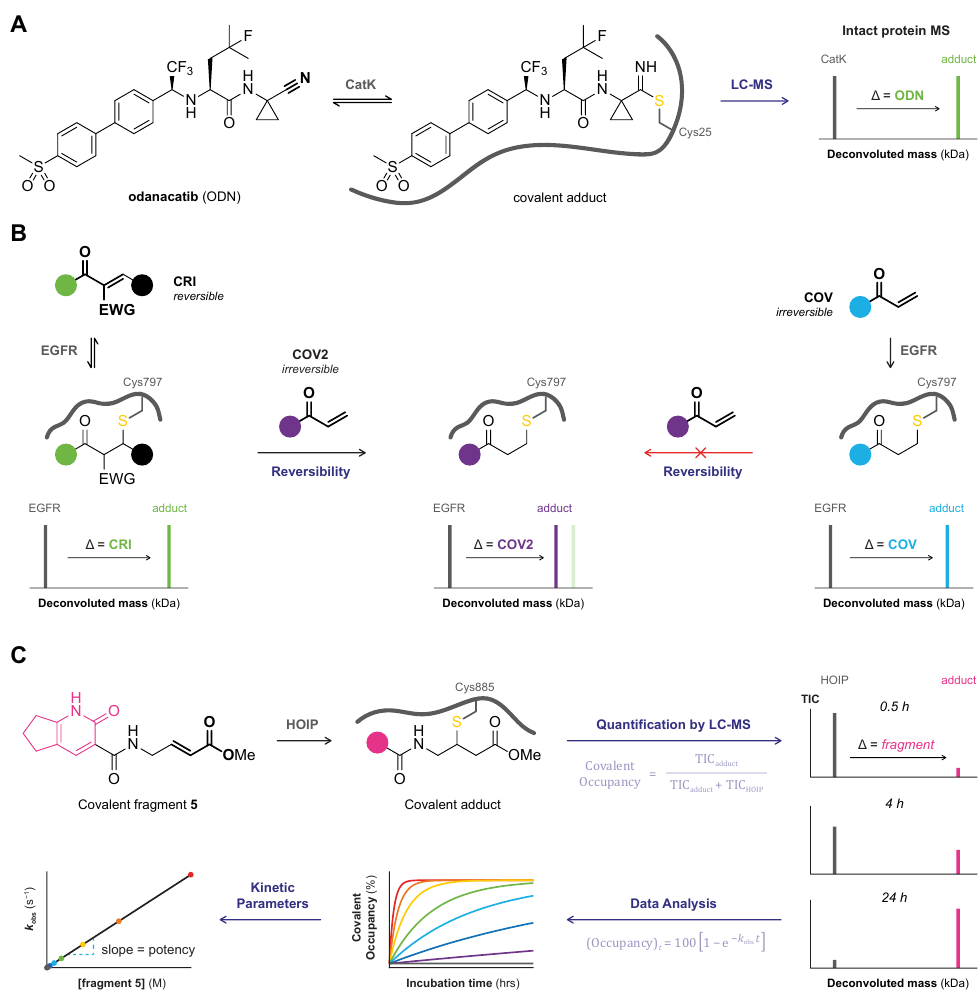
Figure 3. Biophysical covalent adduct detection with intact protein analysis by top-down